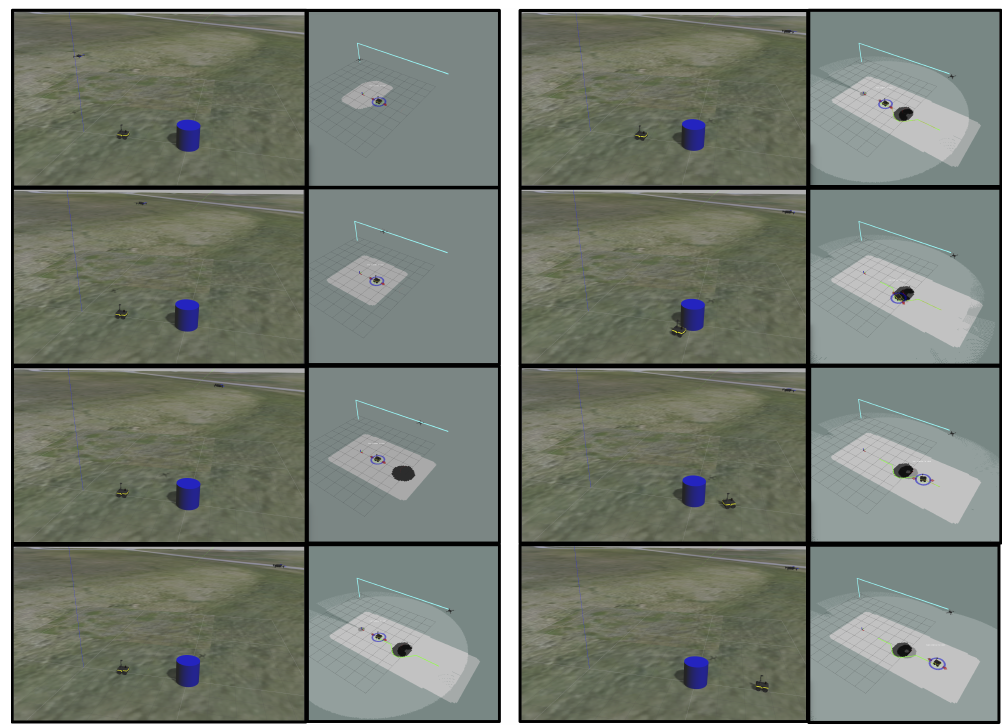
Figure 9. This sequence of images, descending down the left column and then the right column, shows a brief test in simulation. The left window in each pair shows the Gazebo environment, and the right window shows the RViz window. From fourth image on, the ground-based obstacle map is also visualized.